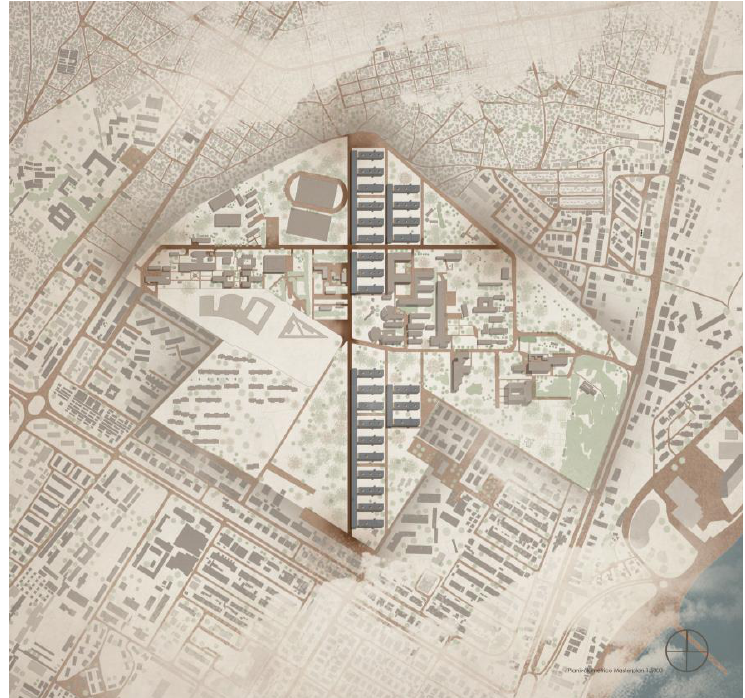
Figure 7. The Sommerschield district in ‘Project Pais’ Masterplan (2019); the new buildings are split into two complexes, a northern complex and a southern complex.